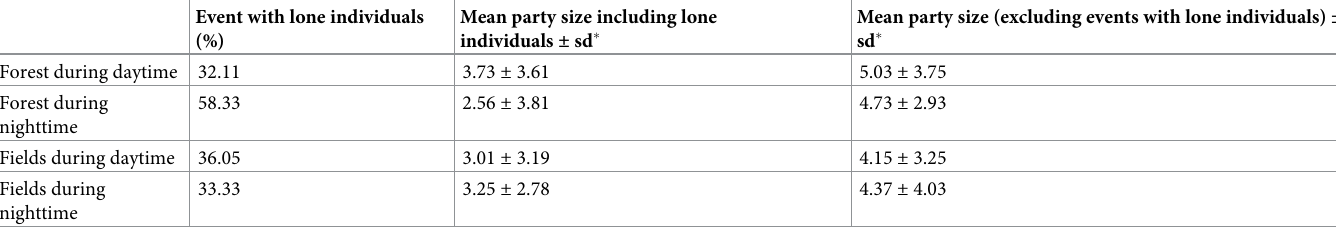
Table 3. Party size and mean group size in function of time condition (day or night) and habitat. Event with lone individuals (%)